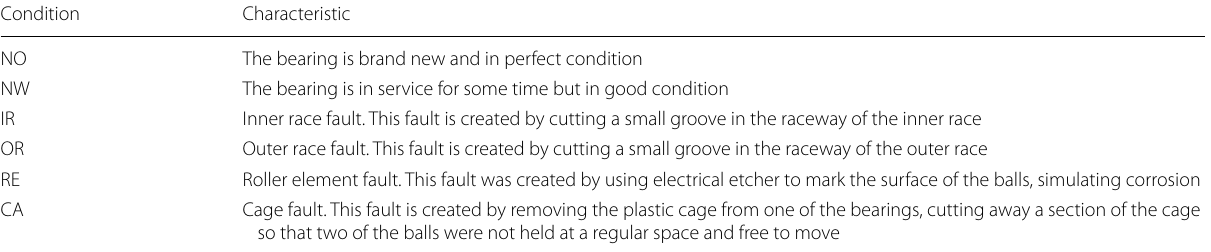
Table 1 Characteristics of bearings health conditions in the first bearing dataset